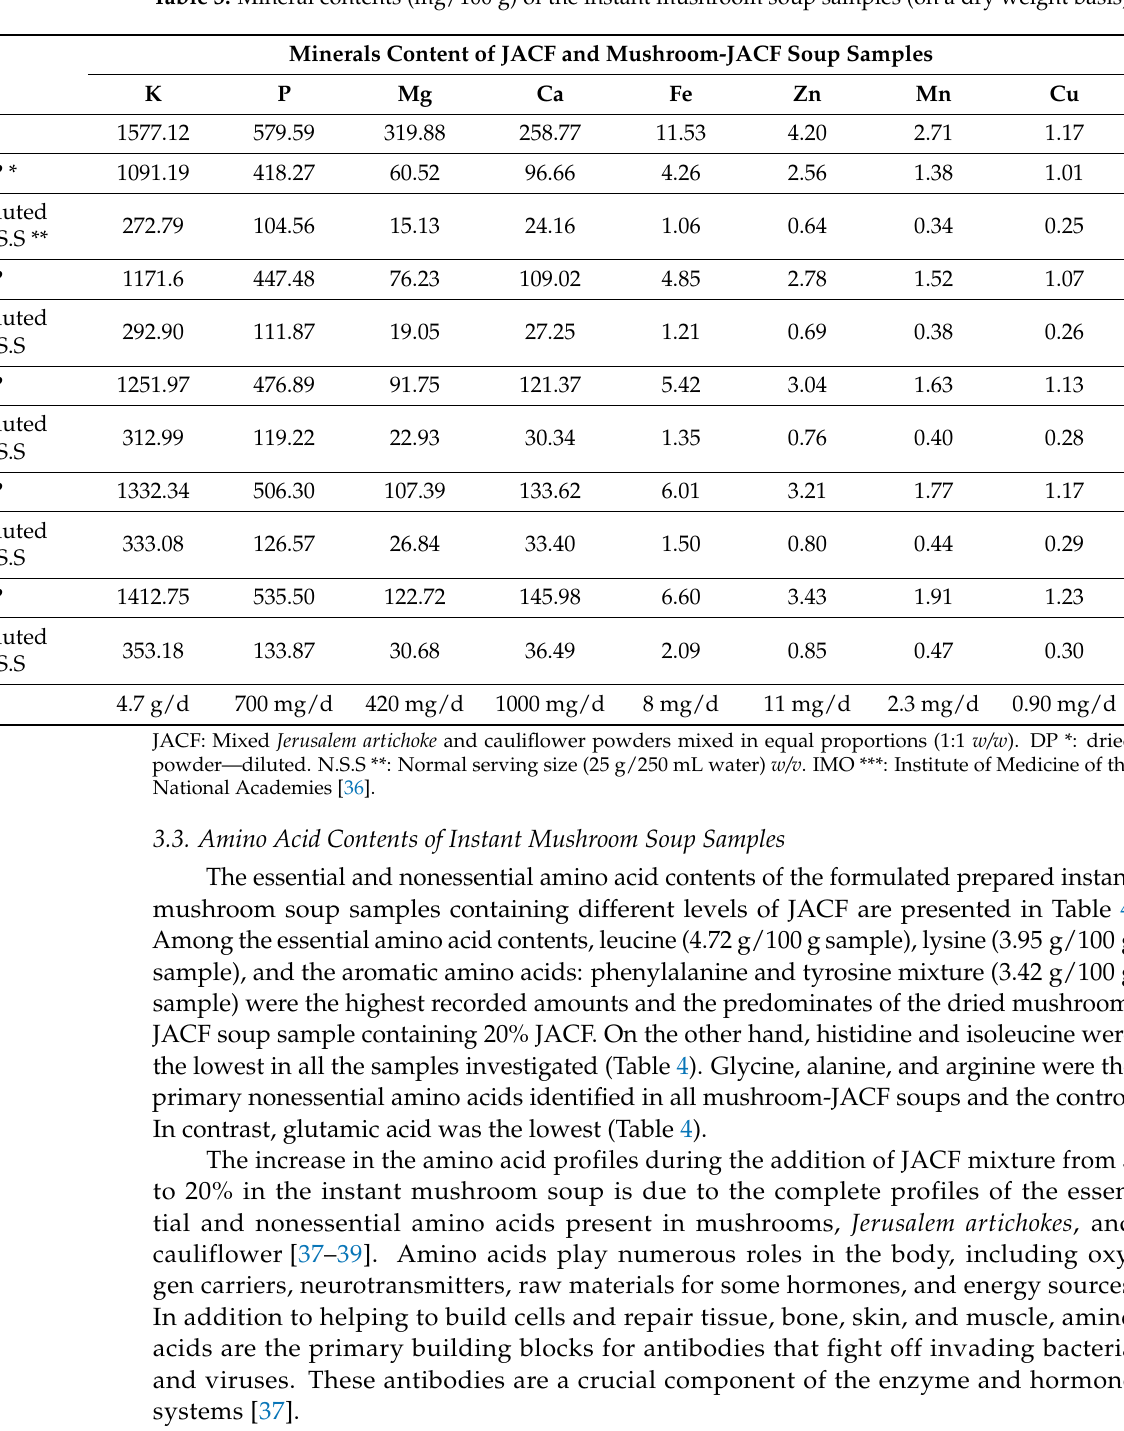
Table 3. Mineral contents (mg/100 g) of the instant mushroom soup samples (on a dry weight